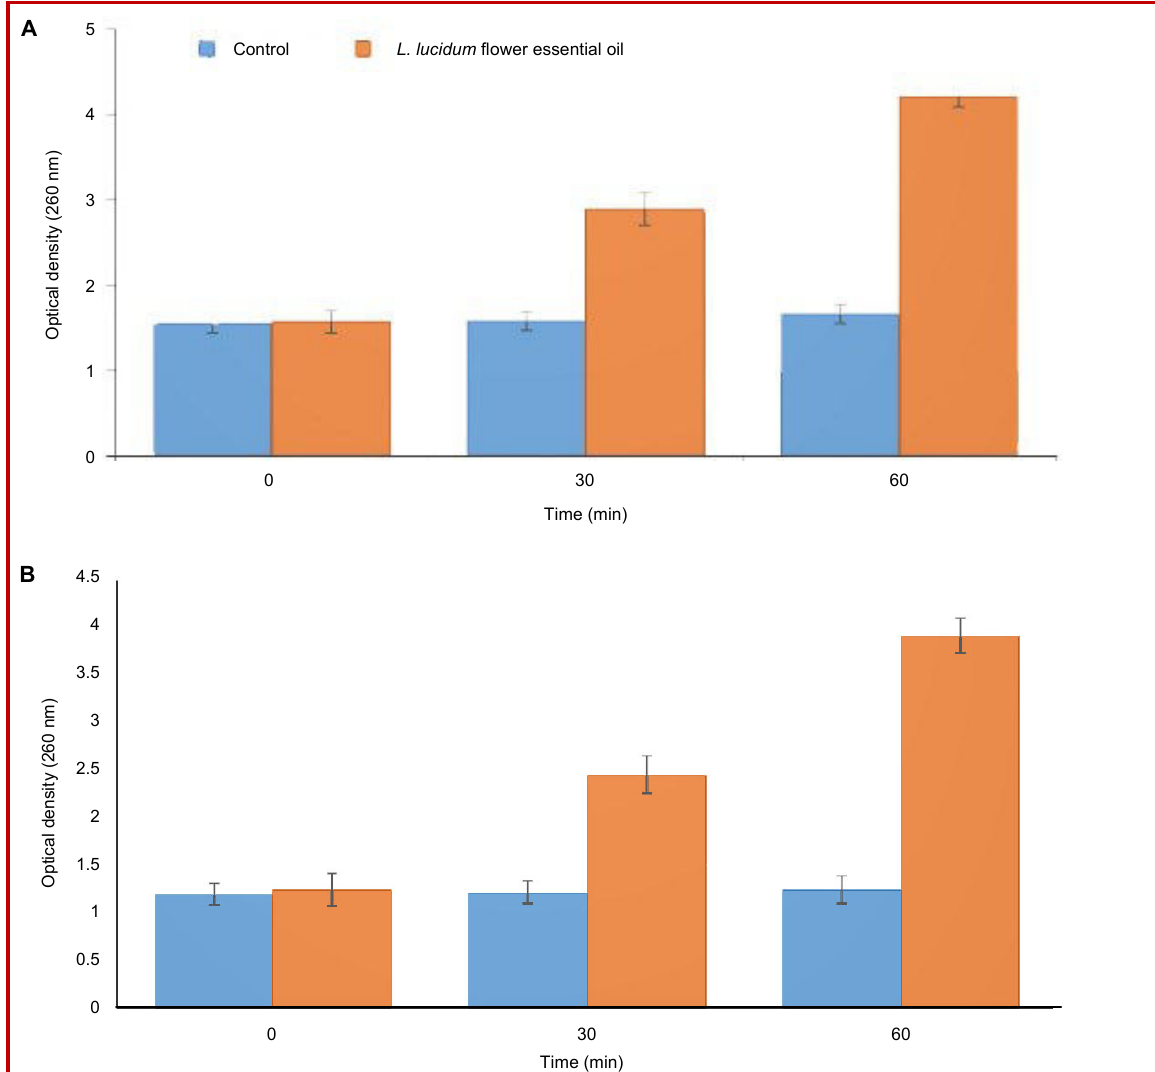
Figure 4: Effect of flower essential oil of Ligustrum lucidum on the release rate of 260 nm absorbing material from S. aureus KCTC- 1621 (A) and S. enterica ATCC-4731 (B). Data are expressed as mean ± SD (n =